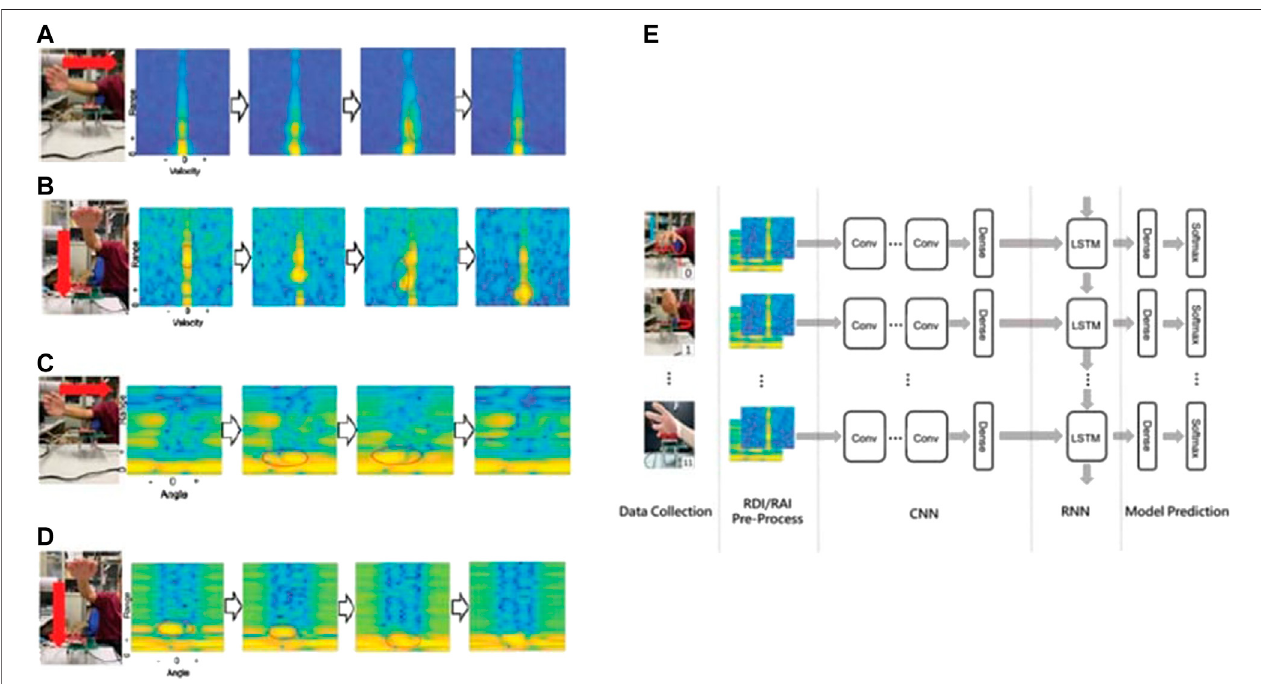
FIGURE 12 | Range Doppler Image (RDI) and Range Angle Image (RAI) gesture recognition. Experimental results are shown for horizontal RDI, with palm swept from right to left (A) , vertical RDI (B) , horizontal RAI (C) , and vertical RAI (D) . Gesture recognition system network model is also shown, (E) . From Yu et al. (2020).